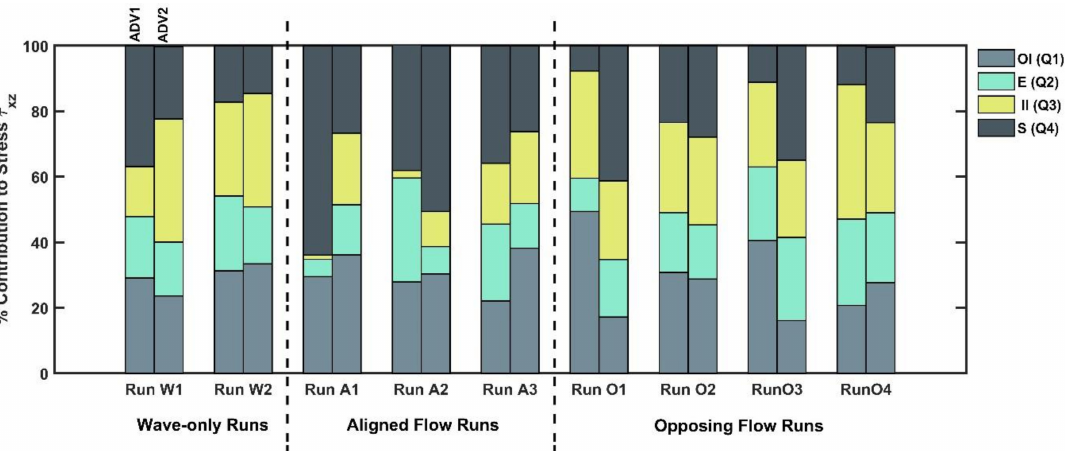
Figure 5. Contribution of the four types of quadrant events: Outward interactions (OI); Ejections (E); Inward Interactions (II) and Sweeps (S) to the Reynolds stress ( τ xz ). A threshold H = 1 is applied. Note the dominance of flow aligned motions (Q1 and Q4 in the aligned flow cases; and Q2 and Q3 in the opposing flow